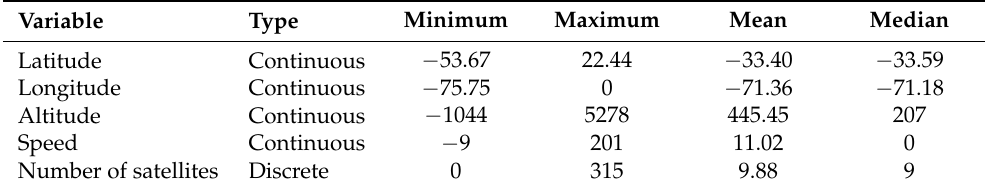
Table 3. Table of quantitative description of variables. Note that we consider the original data, which is why the measurement errors of GPS devices are